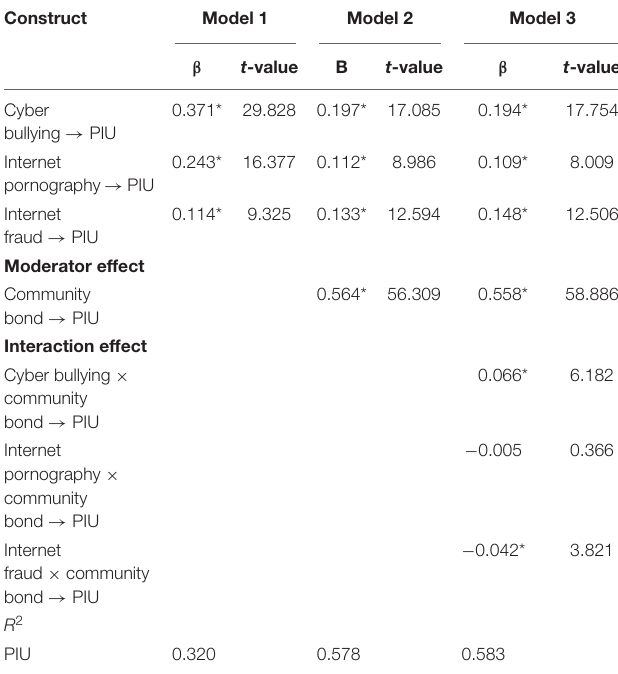
TABLE 3 | Estimation results for